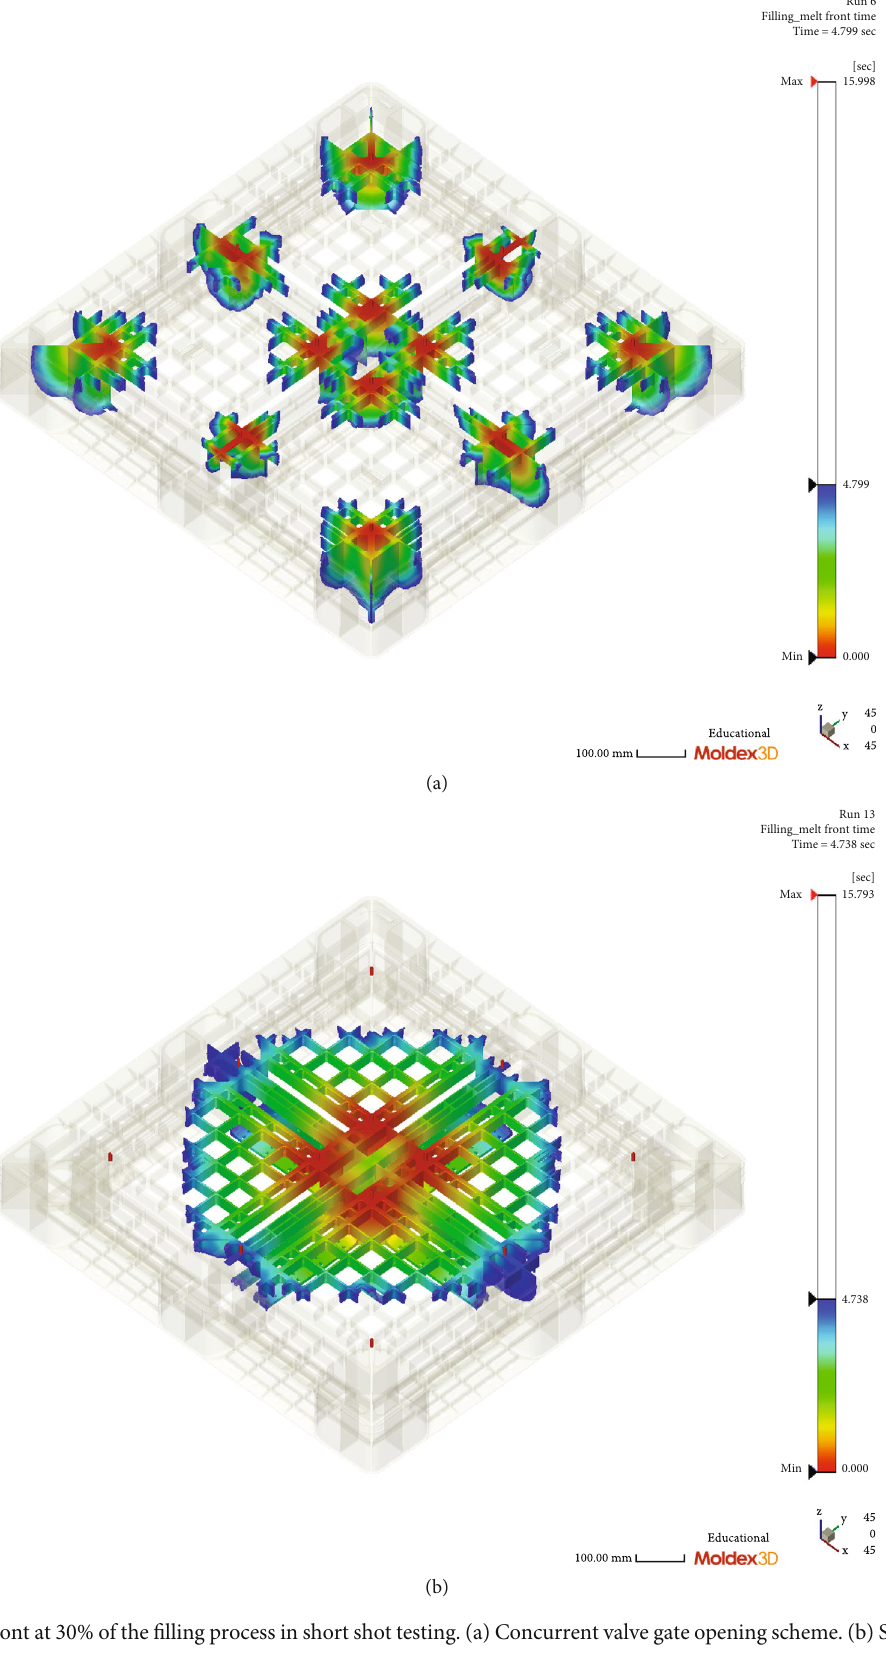
Figure 3: The fl ow front at 30% of the fi lling process in short shot testing. (a) Concurrent valve gate opening scheme. (b) Sequential valve gate opening